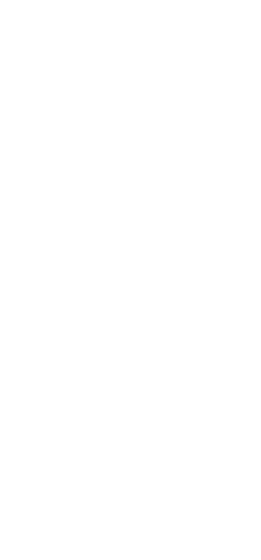
Figure 1. PRISMA diagram of search